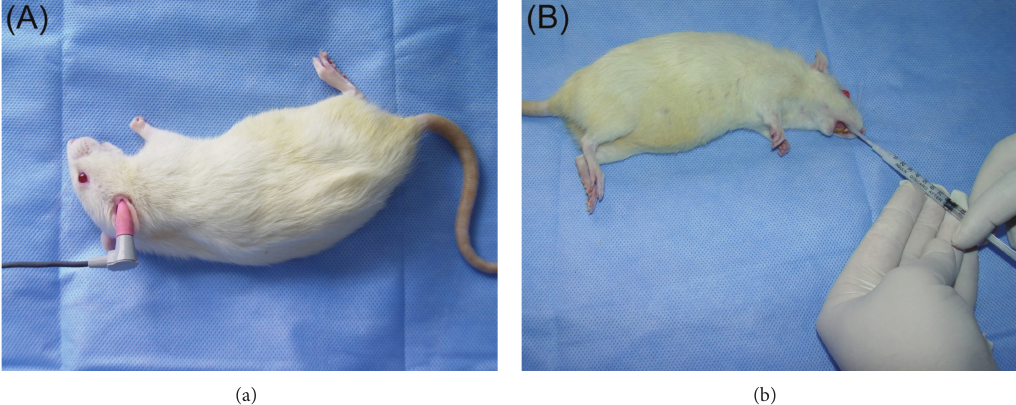
Figure 1: (a) DPOAE measurements with a minimum size rubber tympanometry probe attached to the tip of the probe of the equipment. (b) Administration of sertraline through an oral